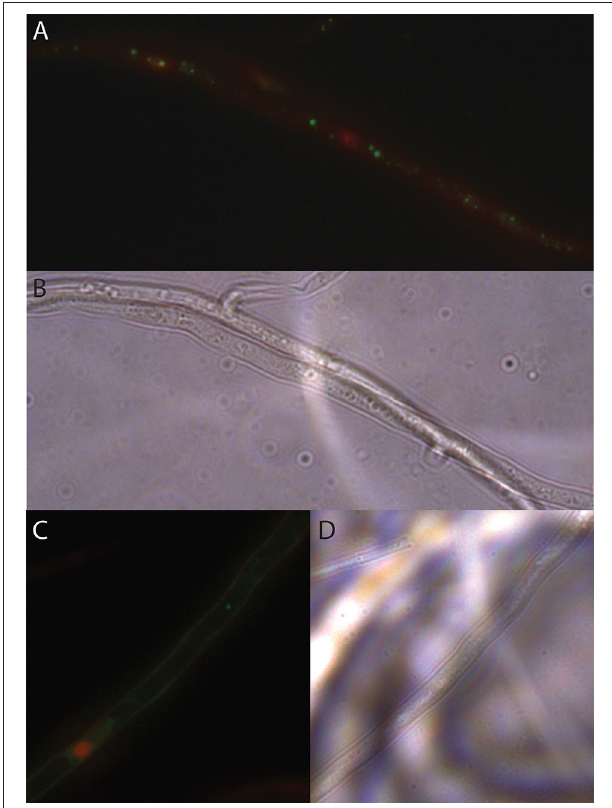
FIGURE 2 | LIVE/DEAD staining of EHB in candidate fungi. (A) Seed-associated FSSC strain PS0362A. Photomicrograph of fluorescently tagged, viable, bacterial nucleic acids in green and compromised fungal organelles in red. Fungal mycelium was alive at the outset of the preparation process but was inactivated (B) same frame viewed with differential interference contrast (DIC). (C) Photomicrograph of foliar endophytic